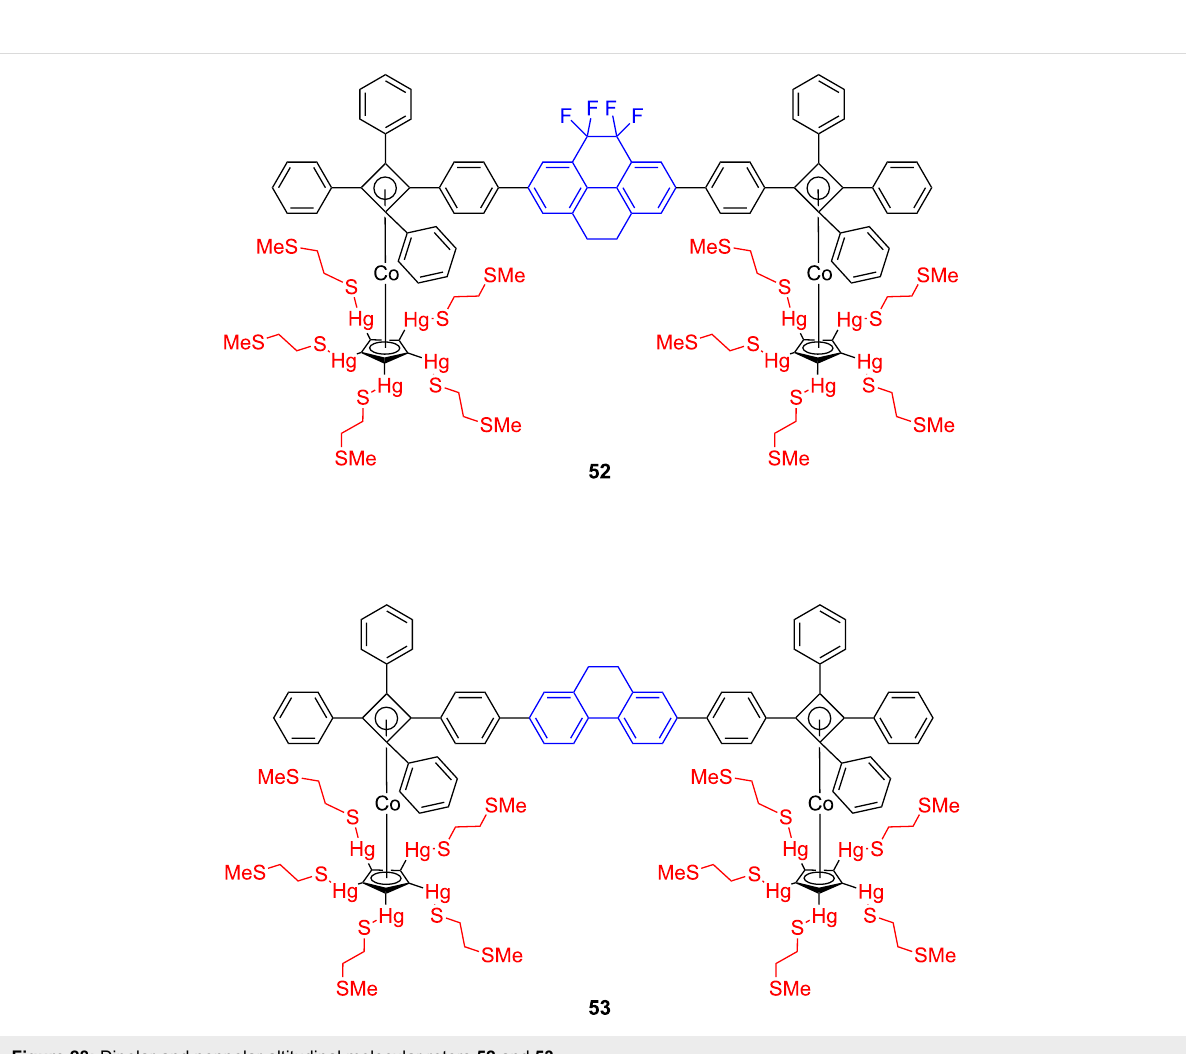
dynamic simulations of the altitudinal rotor on a gold surface using the universal force field (UFF) potential, showed synchro- nous and half-synchronous unidirectional nature of the rota- tional hysteresis around the horizontal axle in one MMP/PPM pair of conformational enantiomers. Furthermore, the effect of the metal on the motion of adsorbed surface-mounted molecu- lar rotors has been approximated by using the image charges and by implementing a Langevin molecular dynamics with elec- tronic friction. Each of the rotors can exist as three pairs of en- antiomers (PPP/MMM, PMP/MPM, and MMP/PPM), where these symbols correspond to the helical P/M symmetry of both tetraarylcyclobutadienes and the rotator in 52 . In Figure 29 are shown two conformations of the dipolar rotor 52 representing maximal (A, where one of the tentacles are eclipsed by the axle) and minimal (B, where the tentacles are staggered with the axle) rotator–tentacle interaction on the surface. While in conforma- tion B the tentacles do not interfere with rotation and the rota- tion is energetically possible for all pair of enantiomers,